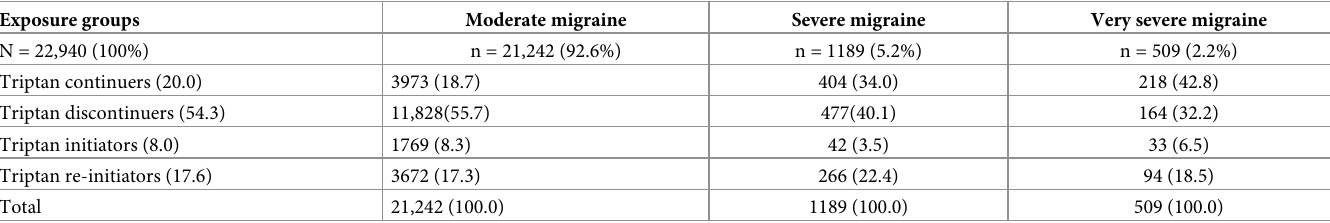
Table 4. Classification of migraine severity according to the triptan exposure groups. Exposure